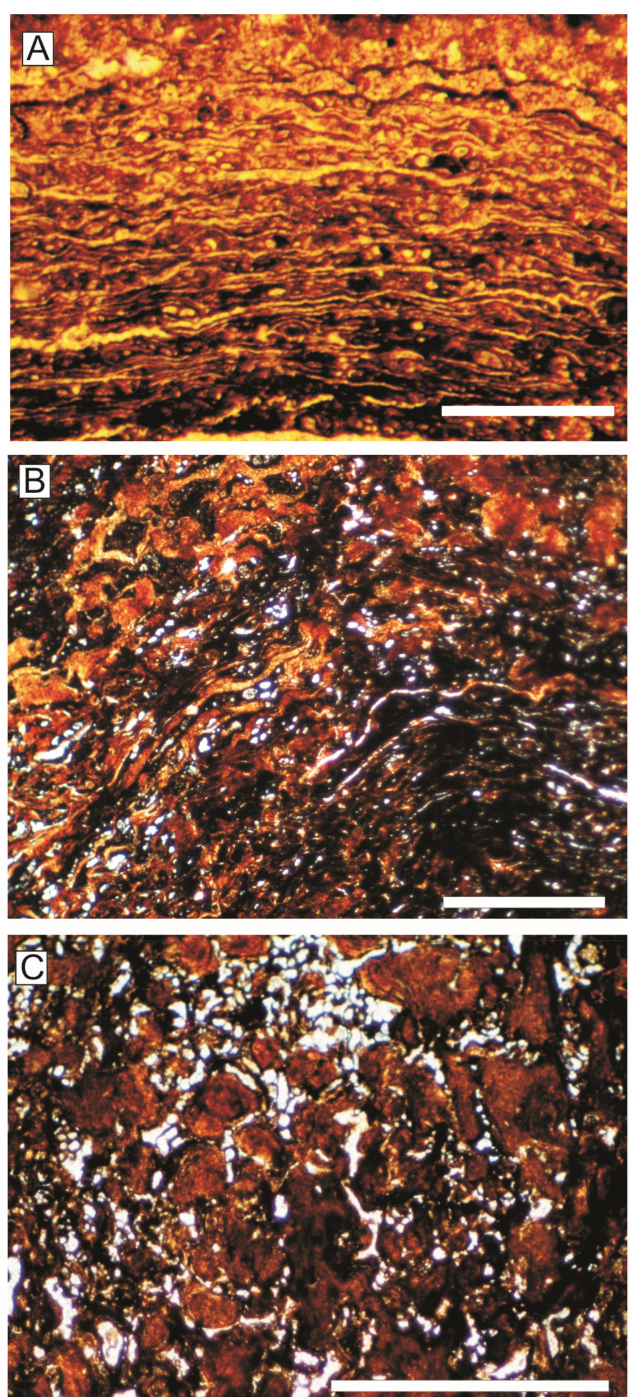
Figure 11. Microbial textures under thin section from iron crusts and macro-oncoids of the Eastern External Subbetic. ( A ) Detail of planar laminated fabric with fibrillar meshwork arranged with their long axes parallel to the lamination and the presence of microspheres (L ú gar outcrop, Bathonian hardground). Filaments and microspheres are filled by calcitic microsparite. ( B ) Laminated fabric with fibrillar meshwork and presence of microspheres from an iron macro-oncoid (Qu í par outcrop, Callovian-Middle Oxfordian hardground). ( C ) Segmented filamentous structures from an iron macro-oncoid (Qu í par outcrop, Callovian-Middle Oxfordian hardground). Scale bars = 0.5